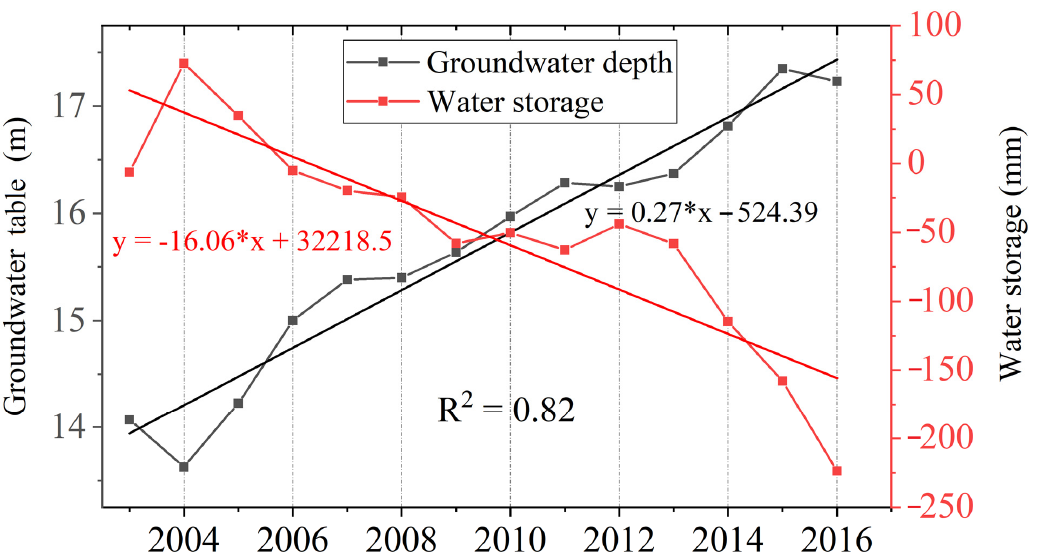
Figure 3. Temporal variations in the groundwater table and water storage in the southern Haihe river plain.